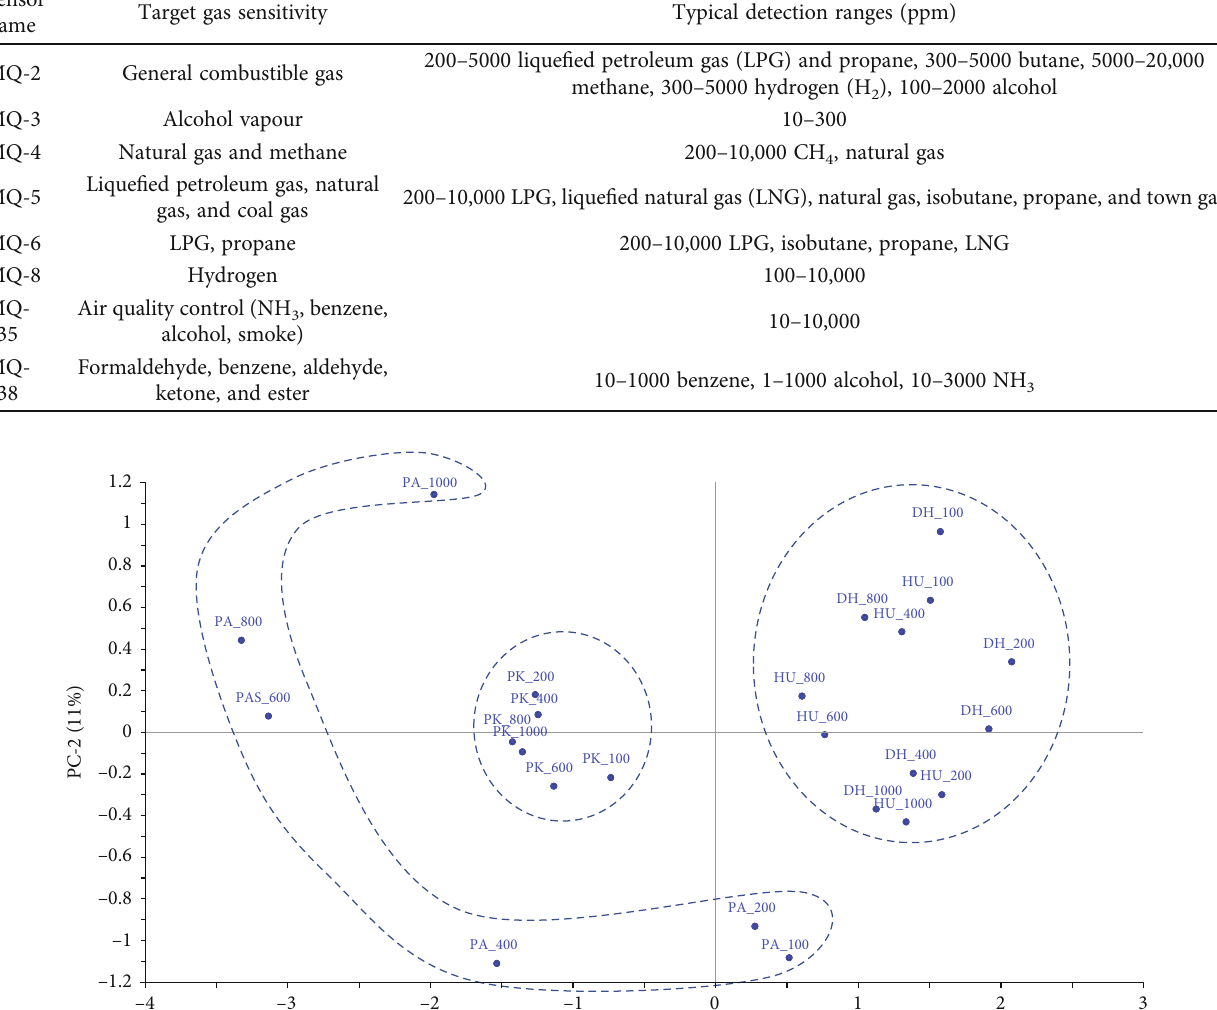
Table 1: The characteristics of the eight metal-oxide semiconductor (MOS) sensors, which electronic nose (EN) is composed of. Sensor